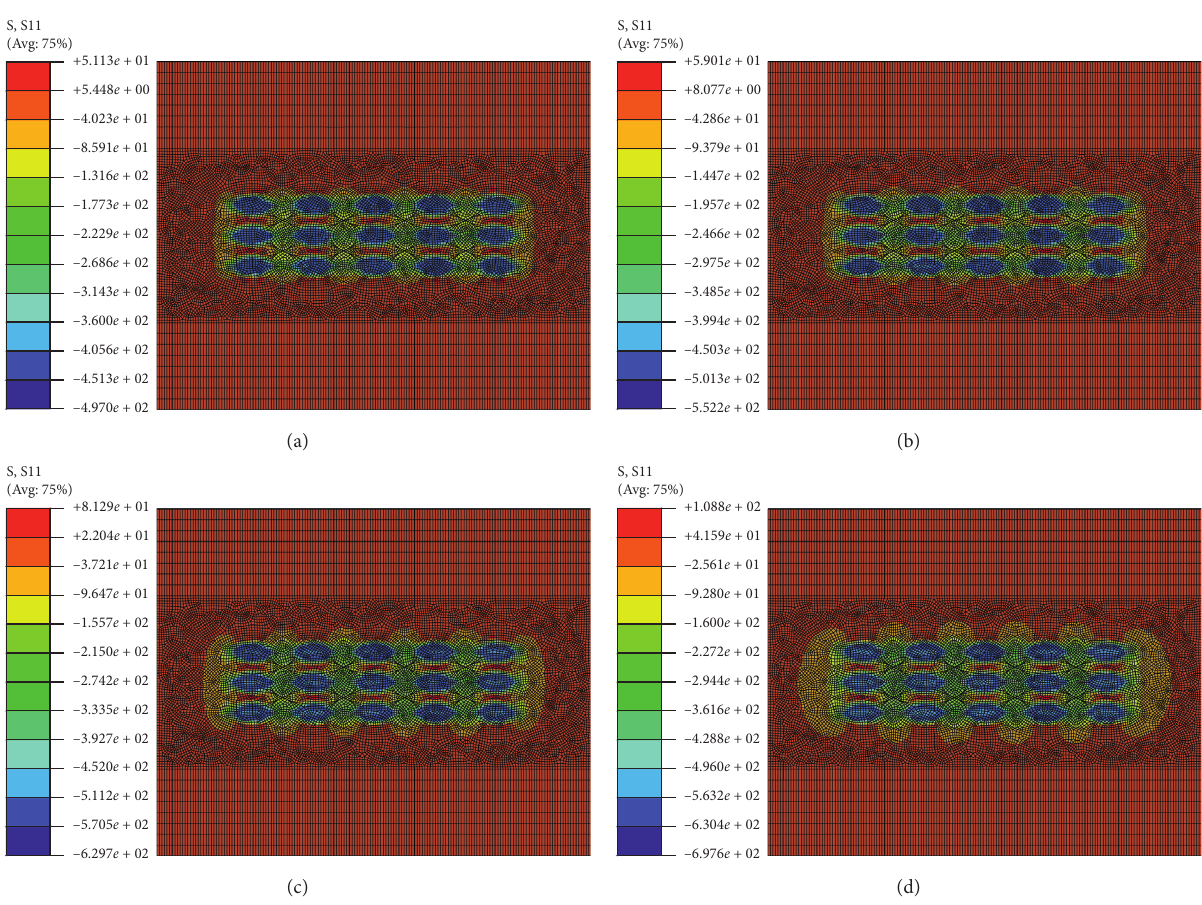
Figure 14: Contours of residual stress distribution of sample surface with three different laser energies. (a) 5J, 5J, 5J; (b) 5 J, 5J, 6 J; (c) 5J, 6J, 7J; (d) 7J, 7J, 7J.